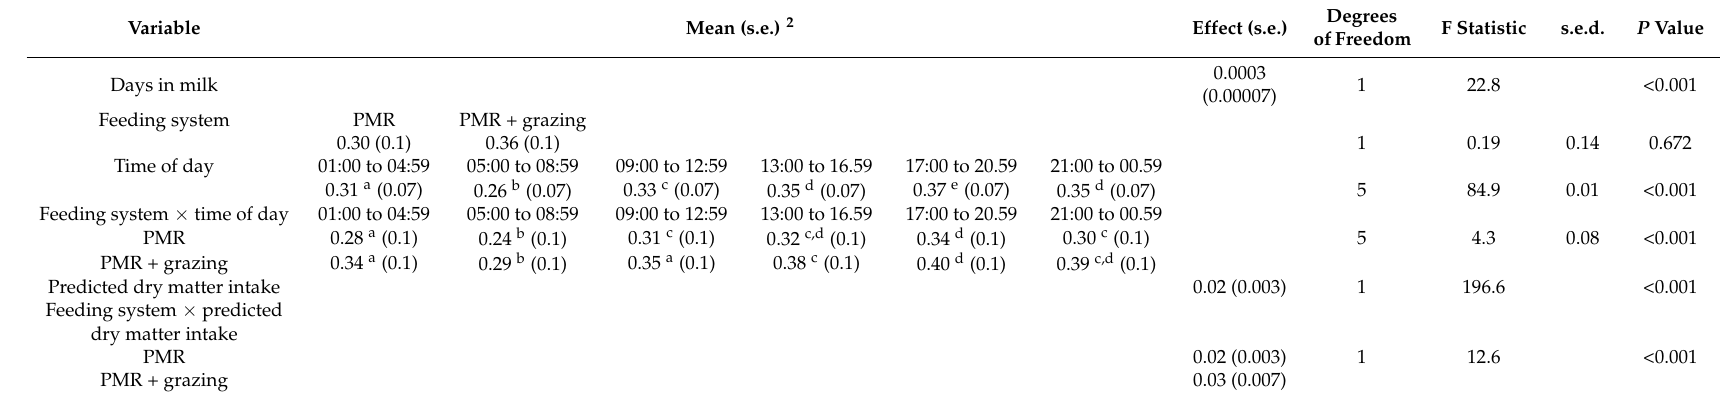
Table 4. Results from multivariate analysis 1 showing effect of partial mixed ration (PMR) or PMR with grazing feeding system on log-transformed CH 4 emissions (mg/L) from dairy